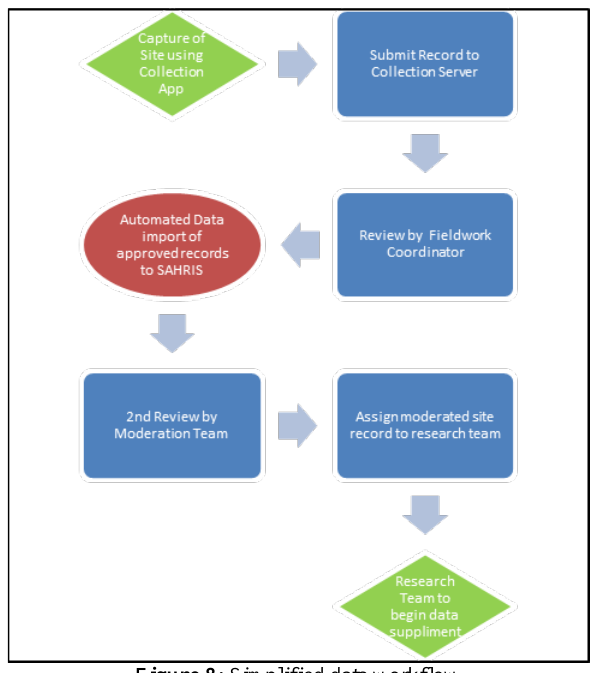
Figure 10: Map of accepted recordings (green) and records, whilst accepted, should be subject to further recording